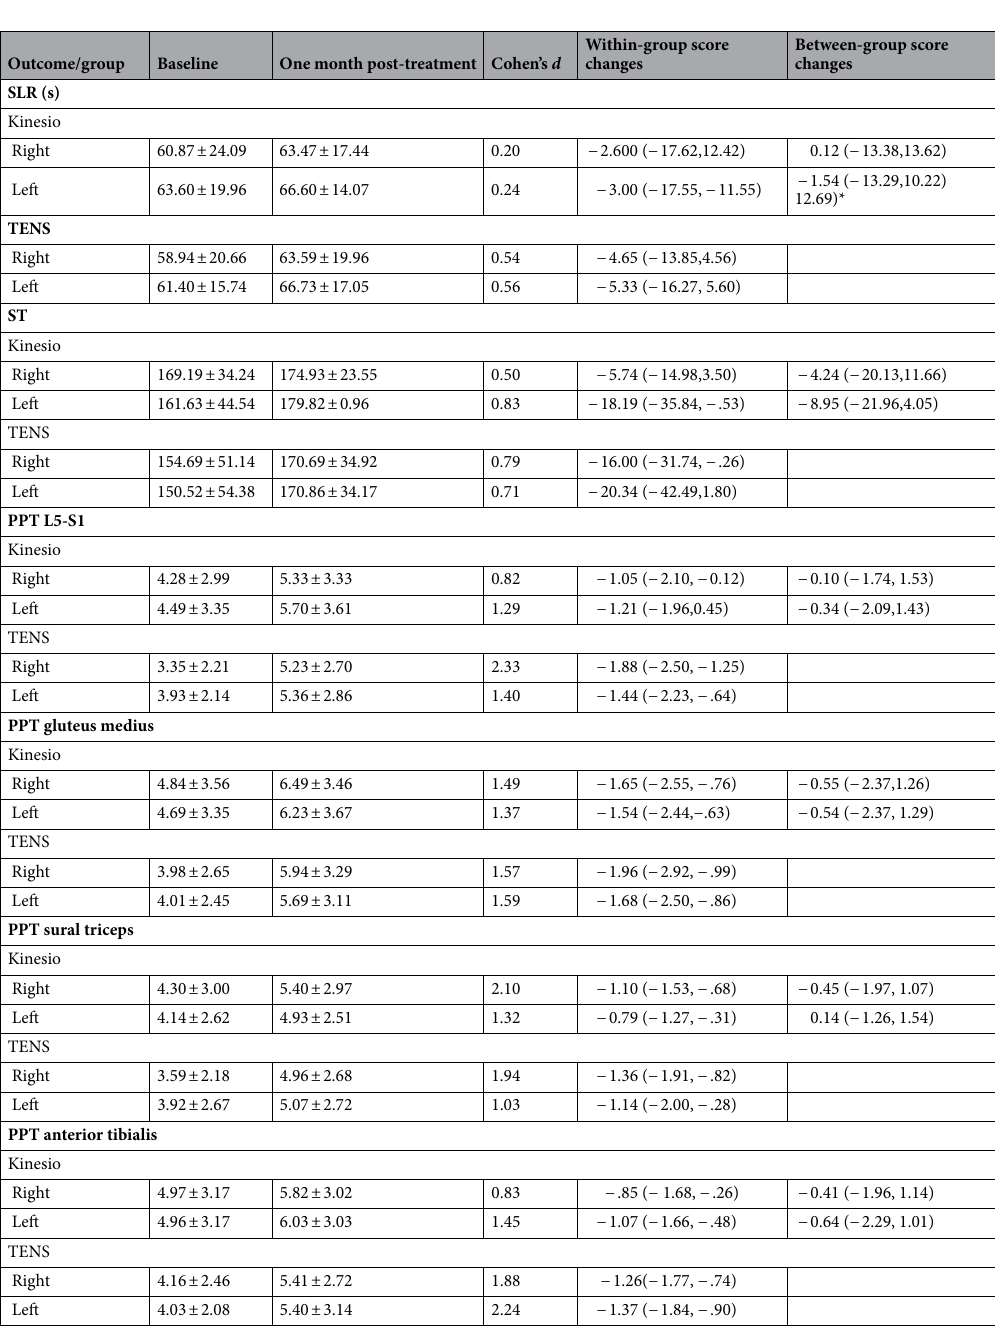
Table 3. Baseline, post-treatment, pre-post-treatment differences and change scores in each group (95% confidence interval) for physical outcomes. Values are expressed as means ± standard deviation for baseline and 1 month post-treatment and as mean (95% confidence interval) for within- and between-group change scores/*Significant Group * Time interaction (ANCOVA, p < 0.05). SLR straight leg raise, ST slump tests, PPT L5-S1 pressure-pain thresholds at the level of L2, 3 cm away from the interspinous line, PPT gluteus medius (musculus gluteus medius), PPT sural triceps (musculus triceps surae), PPT anterior tibialis (musculus tibialis